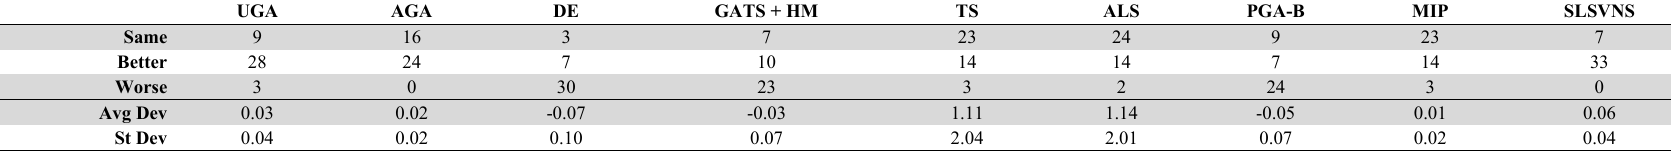
Summary statistics for solutions for Proposed Approach to compared Algorithm / Heuristic ( t i / p i > 0.25) UGA AGA DE GATS +